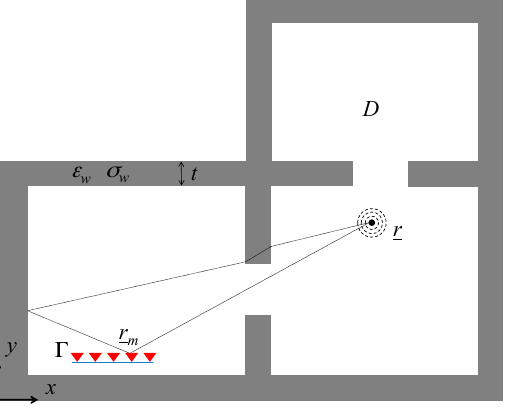
Figure 1. Geometry of the scenario. A radio-frequency (RF) source (black circle) radiates a wireless signal which is recorded by a sensor array (red triangles) deployed along the measurement line Г .